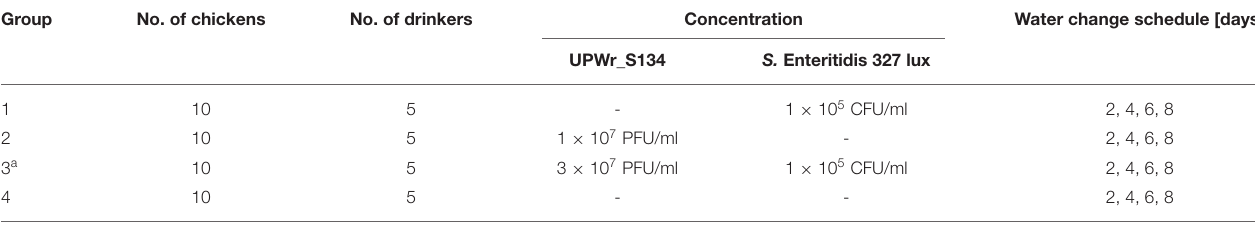
TABLE 1 | Chicken experimental design. UPWr_S134 phage cocktail and S . Enteritidis 327 lux were constantly administered via drinking water. Group